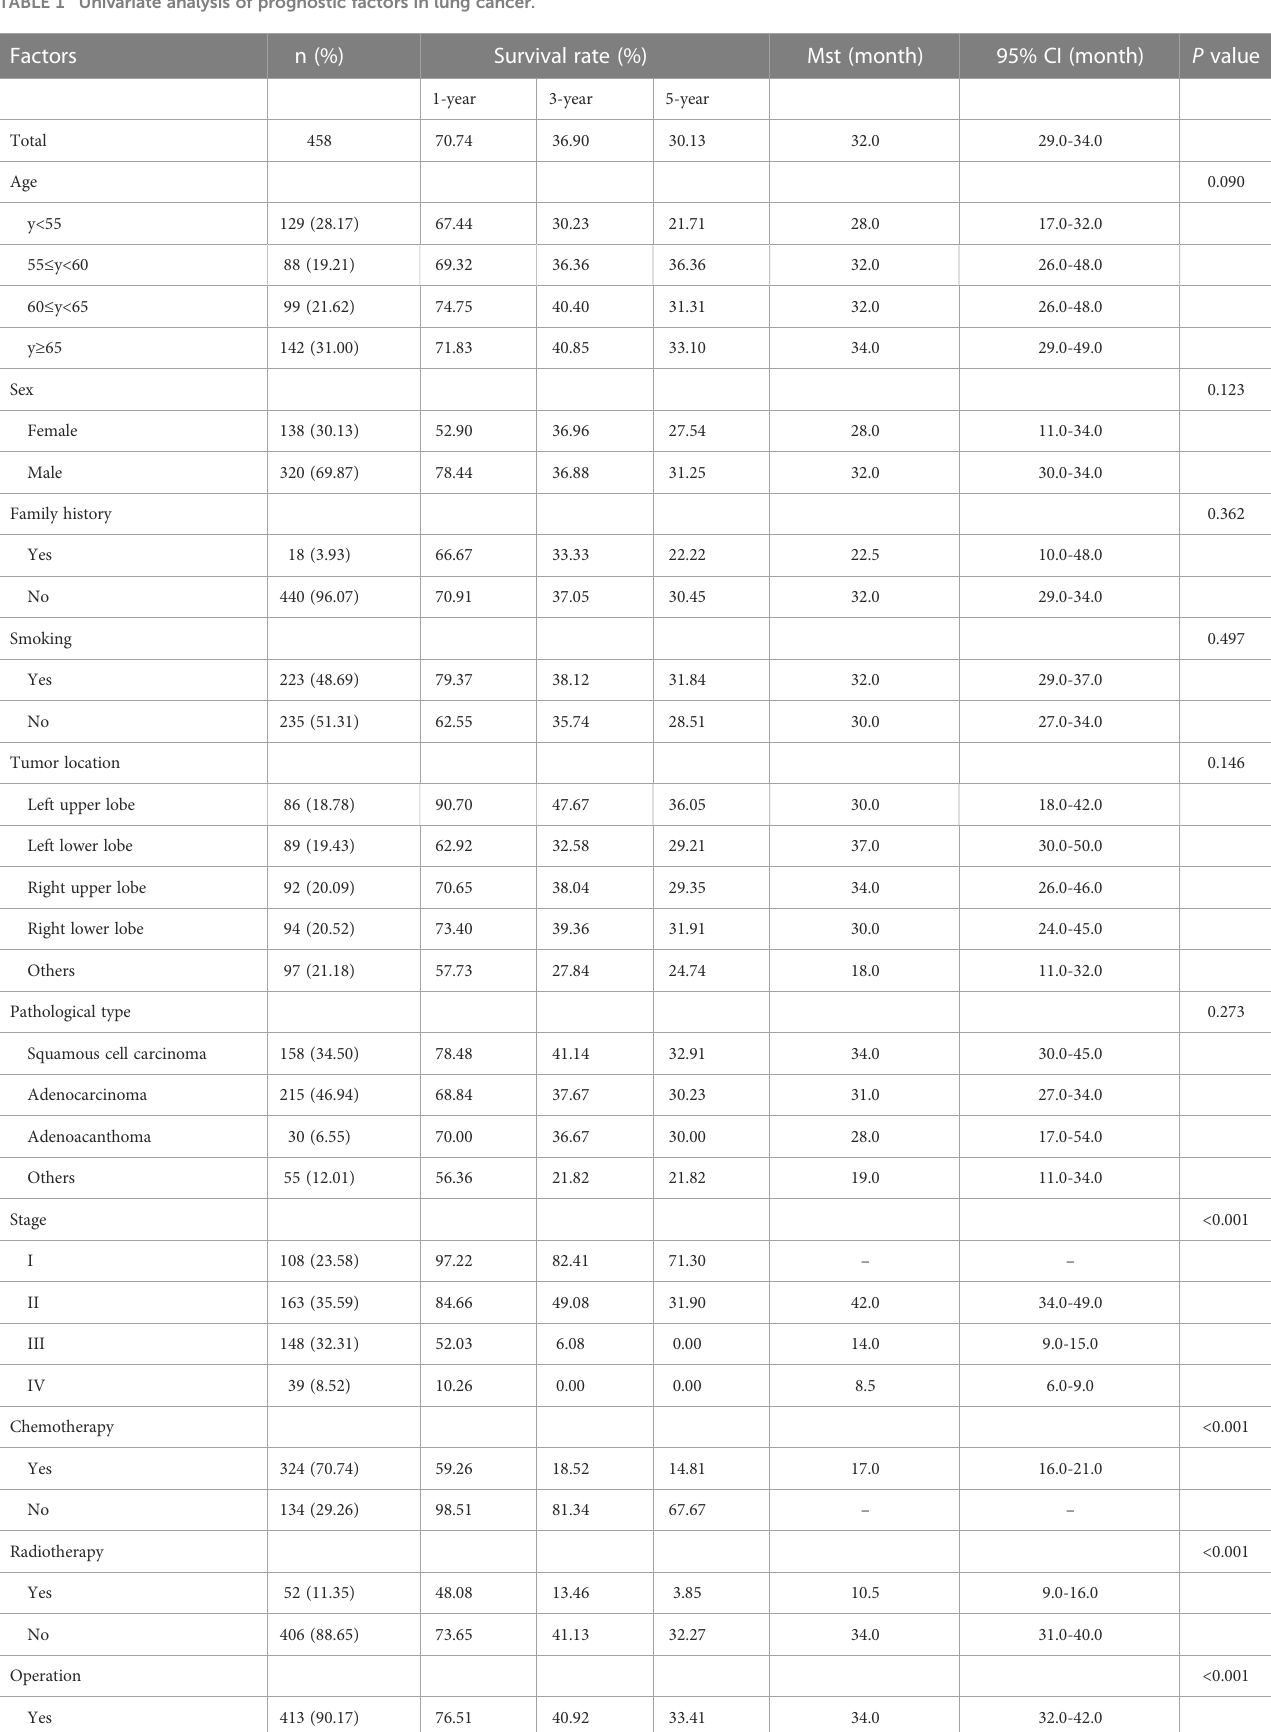
TABLE 1 Univariate analysis of prognostic factors in lung cancer.